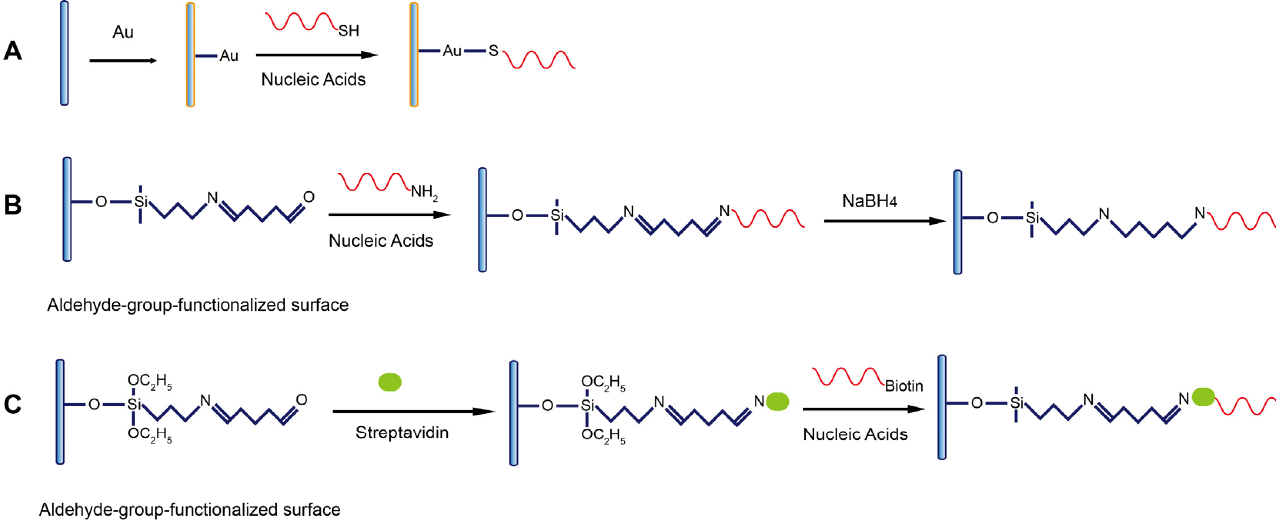
Figure 6. The representative methods to functionalize the fi ber with nucleic acids modi fi ed with ( A ) thiol; ( B ) amino; and ( C ) biotin groups. ( A ) thiol; ( B ) amino; and ( C ) biotin